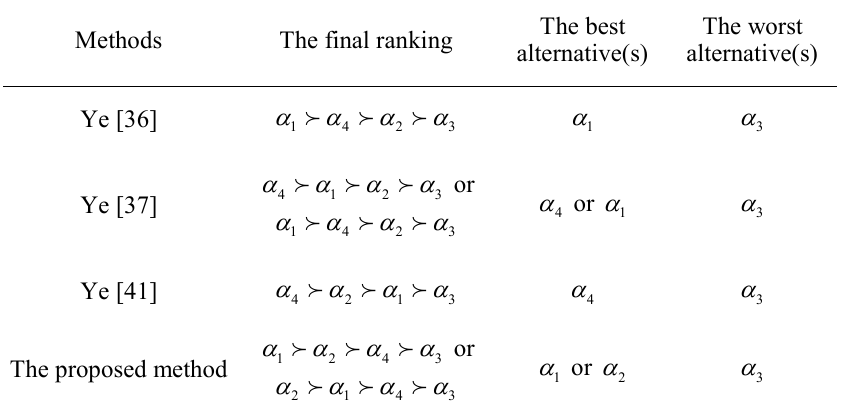
Table 1. The compared results utilizing the different methods with SNSs